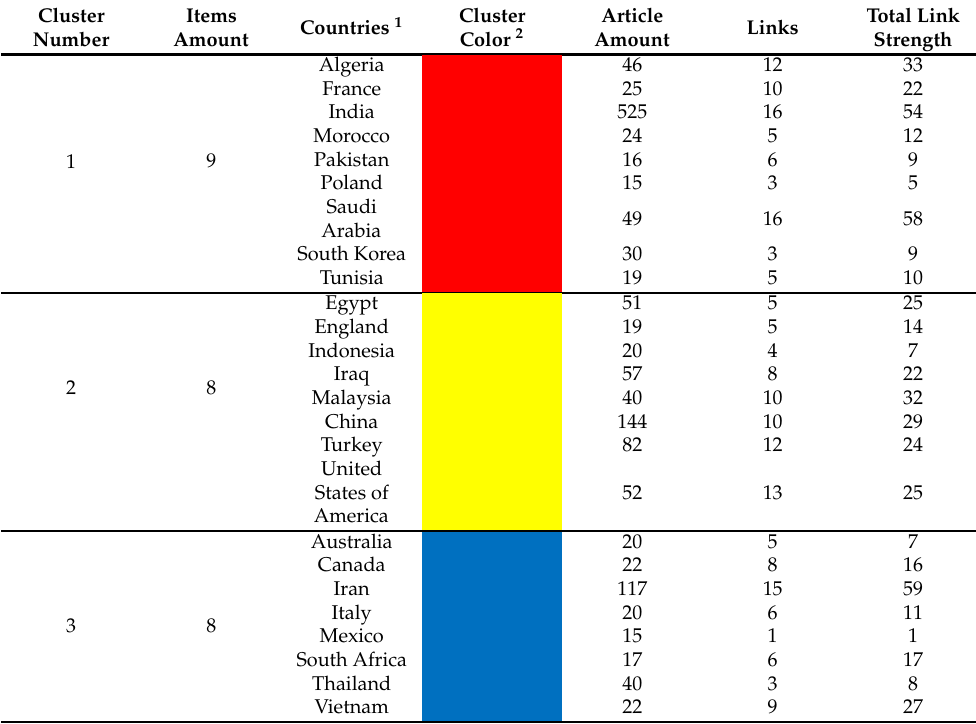
Figure 10. Solar air heaters countries cooperation network. Table 2. Solar air heaters country bibliometric network details.